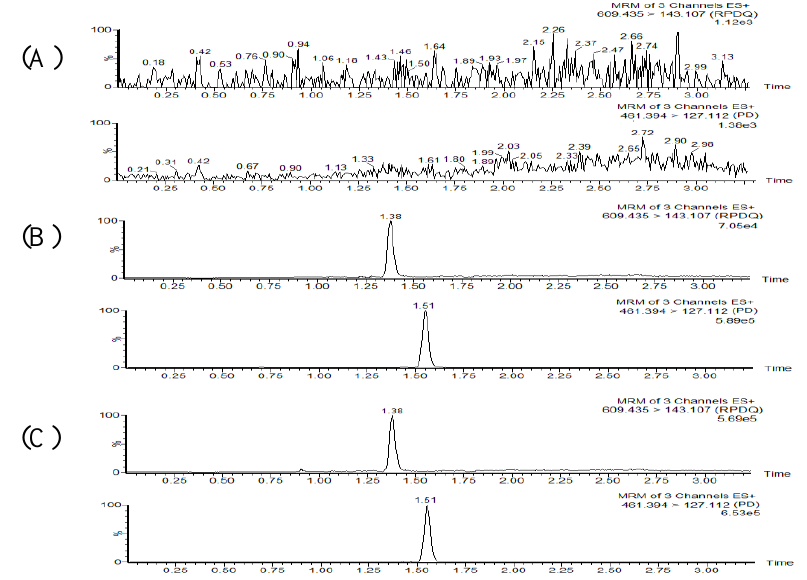
Figure 2. Representative chromatograms of ( A ) blank plasma, ( B ) blank plasma spiked with RPDQ and IS, and ( C ) a real plasma sample collected at an oral dose of 12 mg/kg RPDQ.